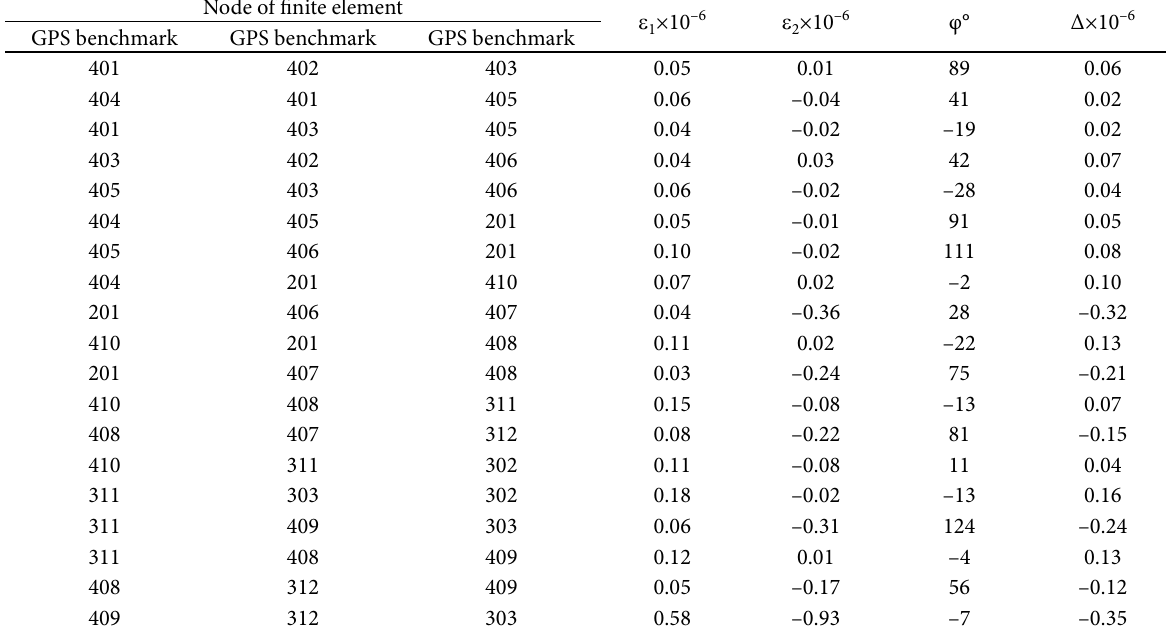
Table 2. Parameters of horizontal deformations Node of finite